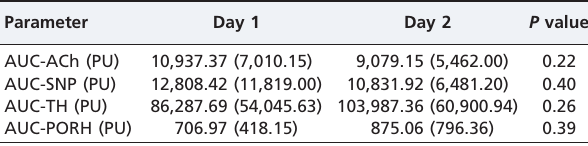
Table 1 - The mean values for microvascular reactivity measured one week apart in healthy subjects using laser Doppler perfusion monitoring.